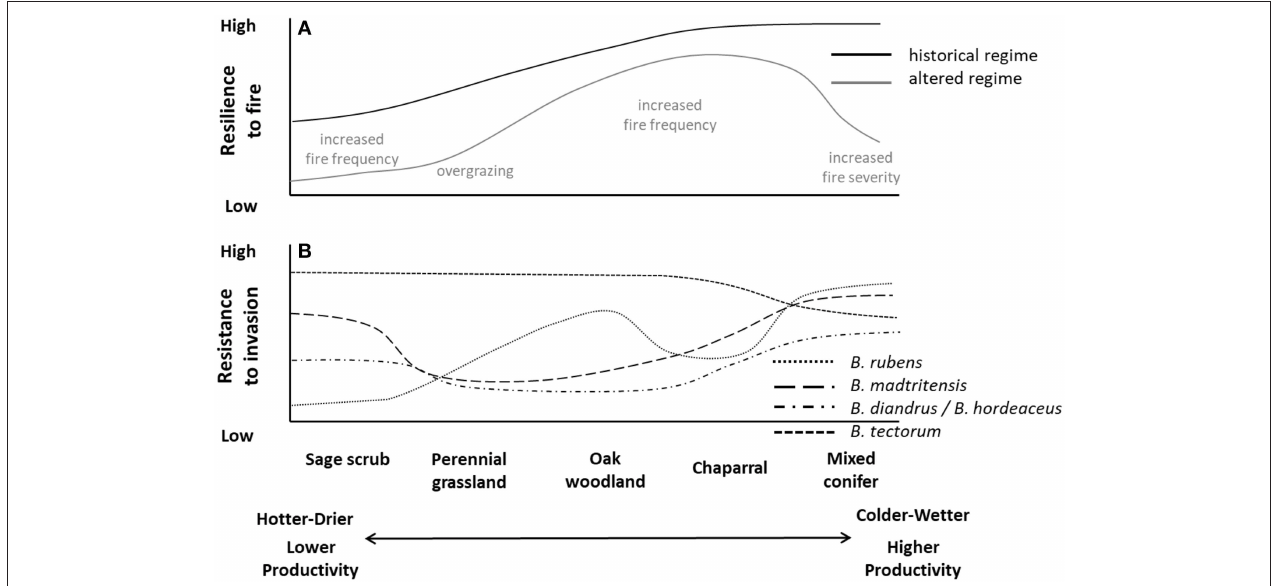
FIGURE 9 | Hypothetical (A) resilience to historical and altered fire regimes (primary altered regime characteristic labeled in gray) and (B) resistance to common invasive annual grass species in the Mediterranean California ecoregion. Adapted from Brooks et al. (2016).